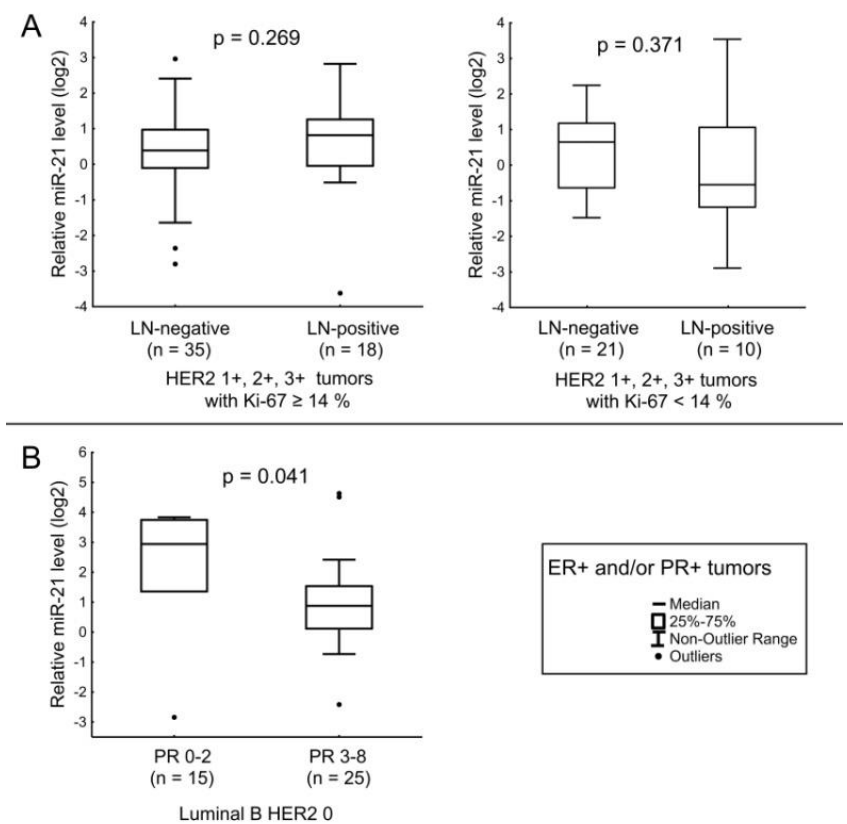
Figure 9. The comparison of miR-21 expression between different cancerous tissue groups: ( A ) re- lation of miR-21 level with LNM in HER2-expressing tumors with Ki-67 ≥ 14% (left), relation of miR-21 level with LNM in HER2-expressing tumors with Ki-67 < 14% (right); ( B ) relation of miR-21 level with PR expression level in luminal B HER2-non-expressing tumors. The Y axis presents the expression level (log 2 – ∆∆ Ct ); the results were normalized to the control (normal tissue). 2